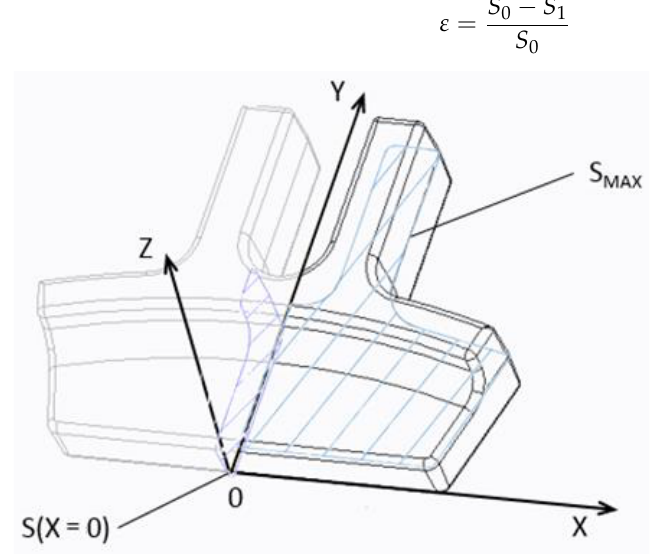
Figure 10. Schematic diagram of cross section volume ( S means section area).